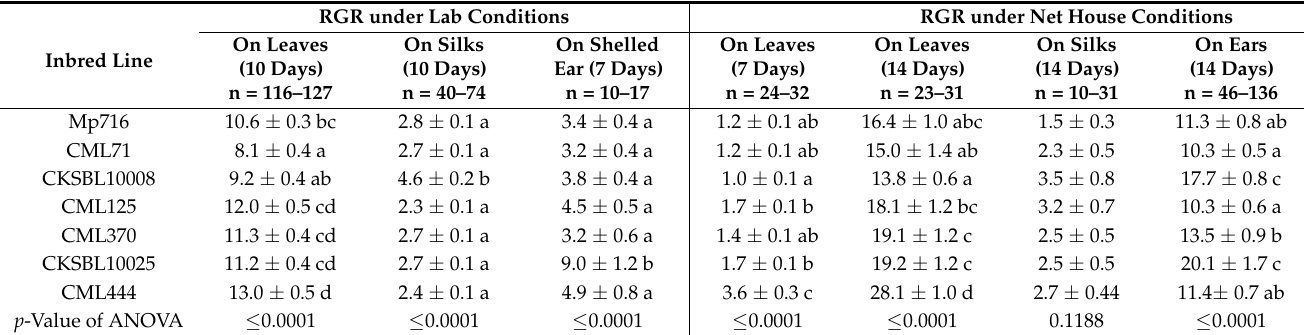
Table 3. Relative growth rates (RGR, mg/d) of Spodoptera frugiperda larvae after 7, 10 and 14 days of infestation on maize inbred lines. For each parameter, mean 1 ± SE are presented.